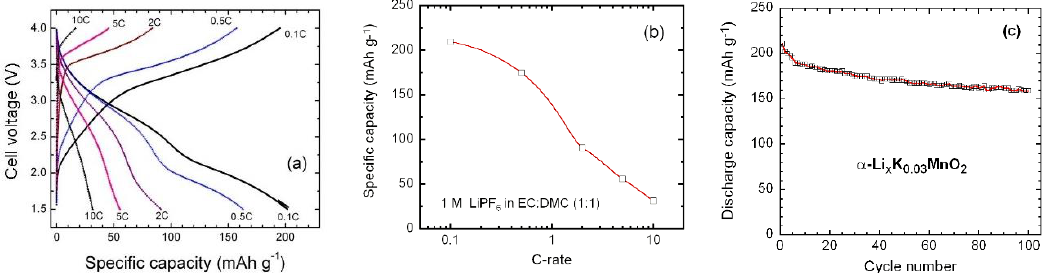
Figure 6. ( a ) Voltage profiles (2nd cycle) of the K 0.03 MnO 2 //Li cells at various C-rates. ( b ) Modified Peukert plot in the range 0.1 to 10 C. ( c ) Cycling stability of the K 0.03 MnO 2 Li cell obtained at 0.1 C.